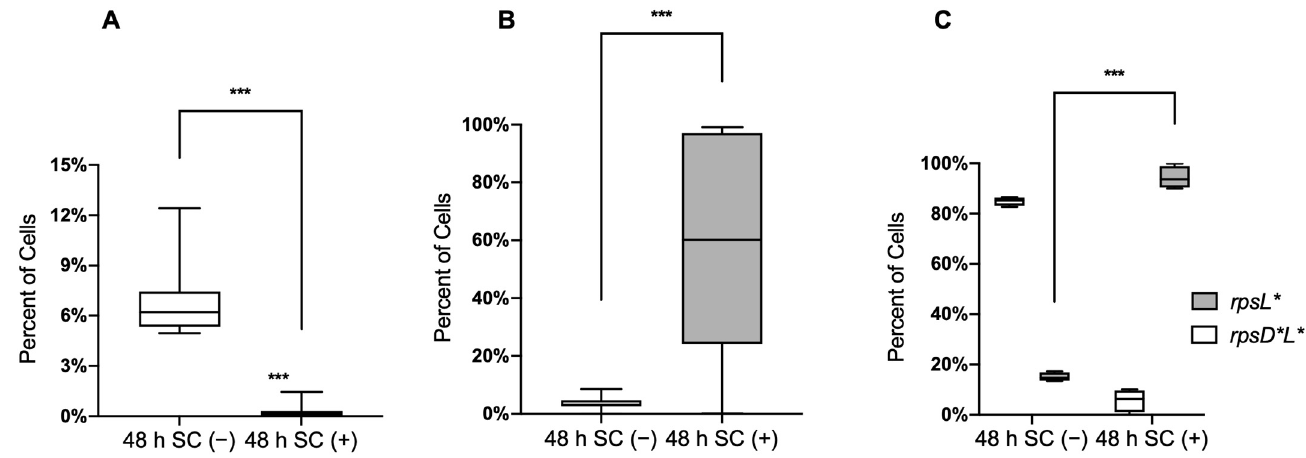
Figure 2. High translational fidelity provides competitive advantage in bile salts. Competition experiments were initiated with a 1:1 mixture of overnight cultures of WT with rpsD *, WT with rpsL *, or rpsL * with rpsD*L * in the presence or absence of 20 mg/mL sodium cholate. Bacteria were grown for a total of 48 h, and bacteria were sorted by flow cytometry. In all, 30,000 gated events were acquired for each sample. ( A ) The error-prone strain rpsD * was outcompeted by the WT strain after 48 h with the addition of sodium cholate. ( B ) The error-restrictive strain rpsL * was outcompeted by the WT without sodium cholate but showed an increased advantage over the WT strain in the presence of sodium cholate. ( C ) Strain rpsD * L * had a higher error rate than rpsL *and was outcompeted by the rpsL * strain in the presence of sodium cholate after 48 h. The data here are representative of results from at least three biological replicates. The p -values were determined using the independent t-test. ***, p < 0.001.